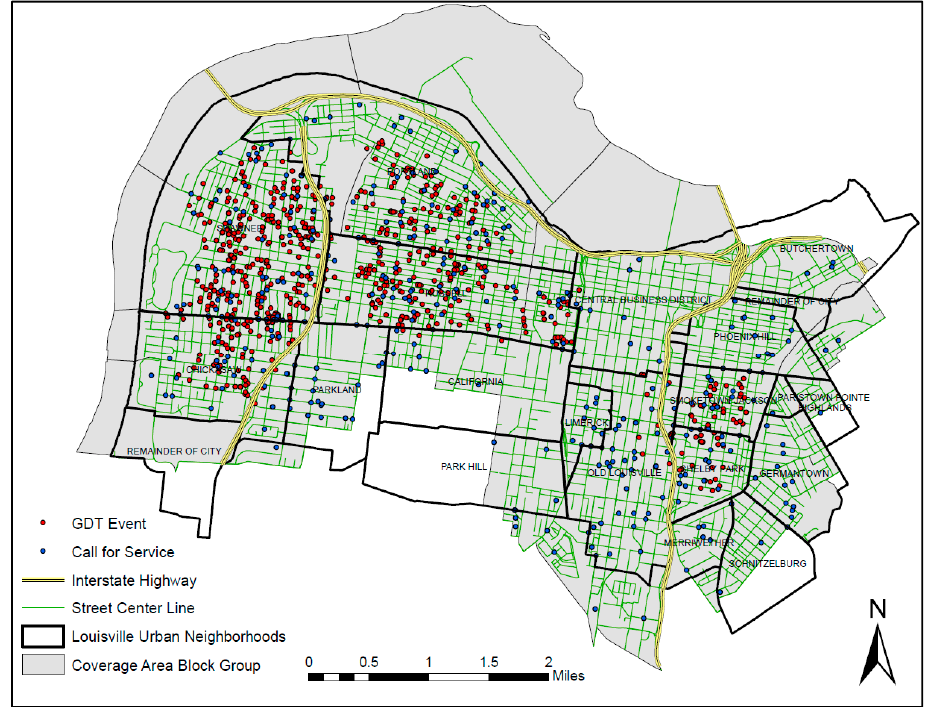
Figure 2. Distribution of GDT events and calls for service for shots fired in the study area.